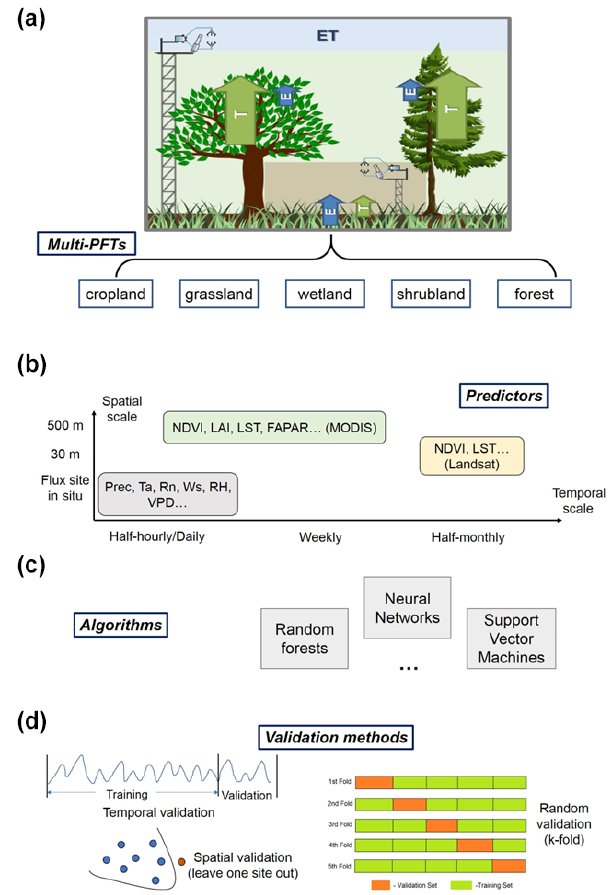
Figure 1. Features of the machine-learning-based water flux pre- diction process. (a) The eddy-covariance-based water flux observa- tions of various plant function types (PFTs), modified from (Paul- Limoges et al., 2020). ET – evapotranspiration. E – evaporation. T – transpiration. (b) Predictors and their spatial and temporal reso- lution. (c) The machine learning algorithms used for the modeling, such as neural networks and random forests. (d) The model vali- dation methods used, including the spatial, temporal, and random